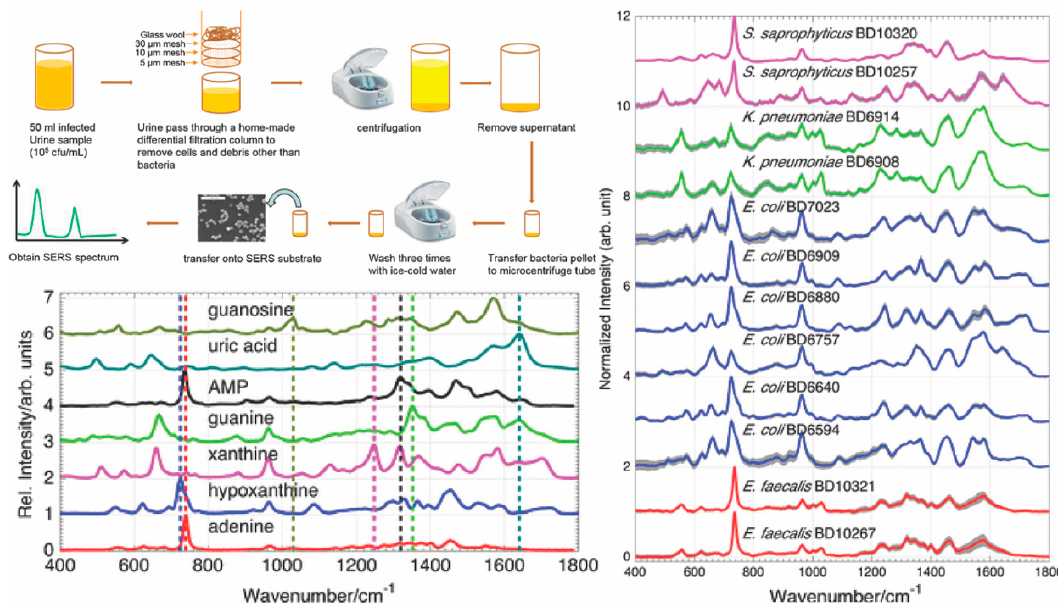
Figure 3. (Top Left) Sample preparation steps for urine samples spiked with bacterial strains of urinary tract infection (UTI) clinical isolates for SERS-based direct detection of nucleic acid metabolites. (Right) SERS spectra of 12 different UTI bacterial strains exhibiting unique biomarker signatures that were produced from sample on an aggregated gold nanoparticle-covered silica substrate. (Bottom Left) Intrinsic SERS spectra of seven key metabolite biomarkers used in the differentiation of the 12 UTI bacterial strains. Reproduced with permission from Reference [87] Springer (2017).